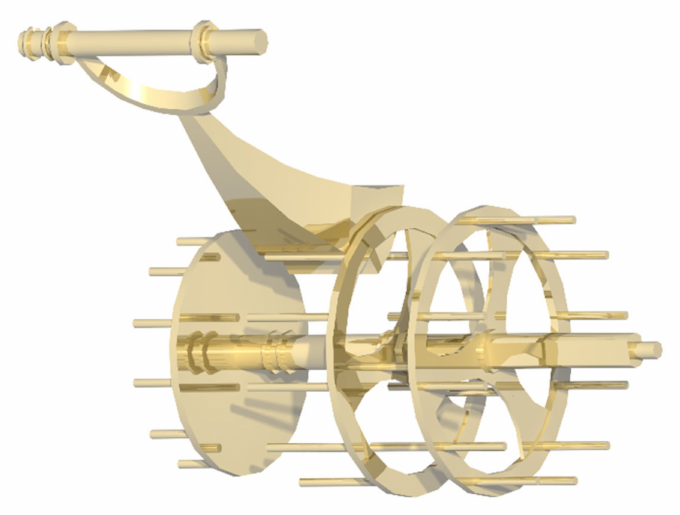
Figure 13. Backstop pawl resting on the accumulator.